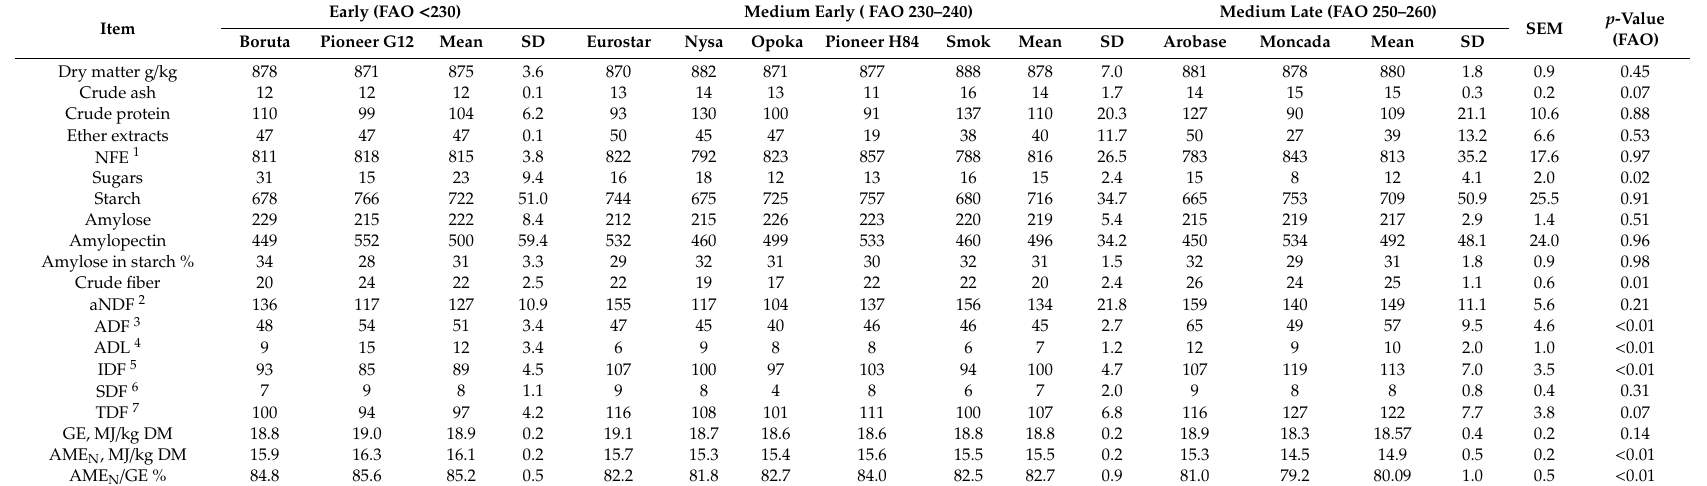
Table 3. Chemical composition (g / kg DM), gross energy (GE), and apparent metabolizable energy content (AME N ) of maize